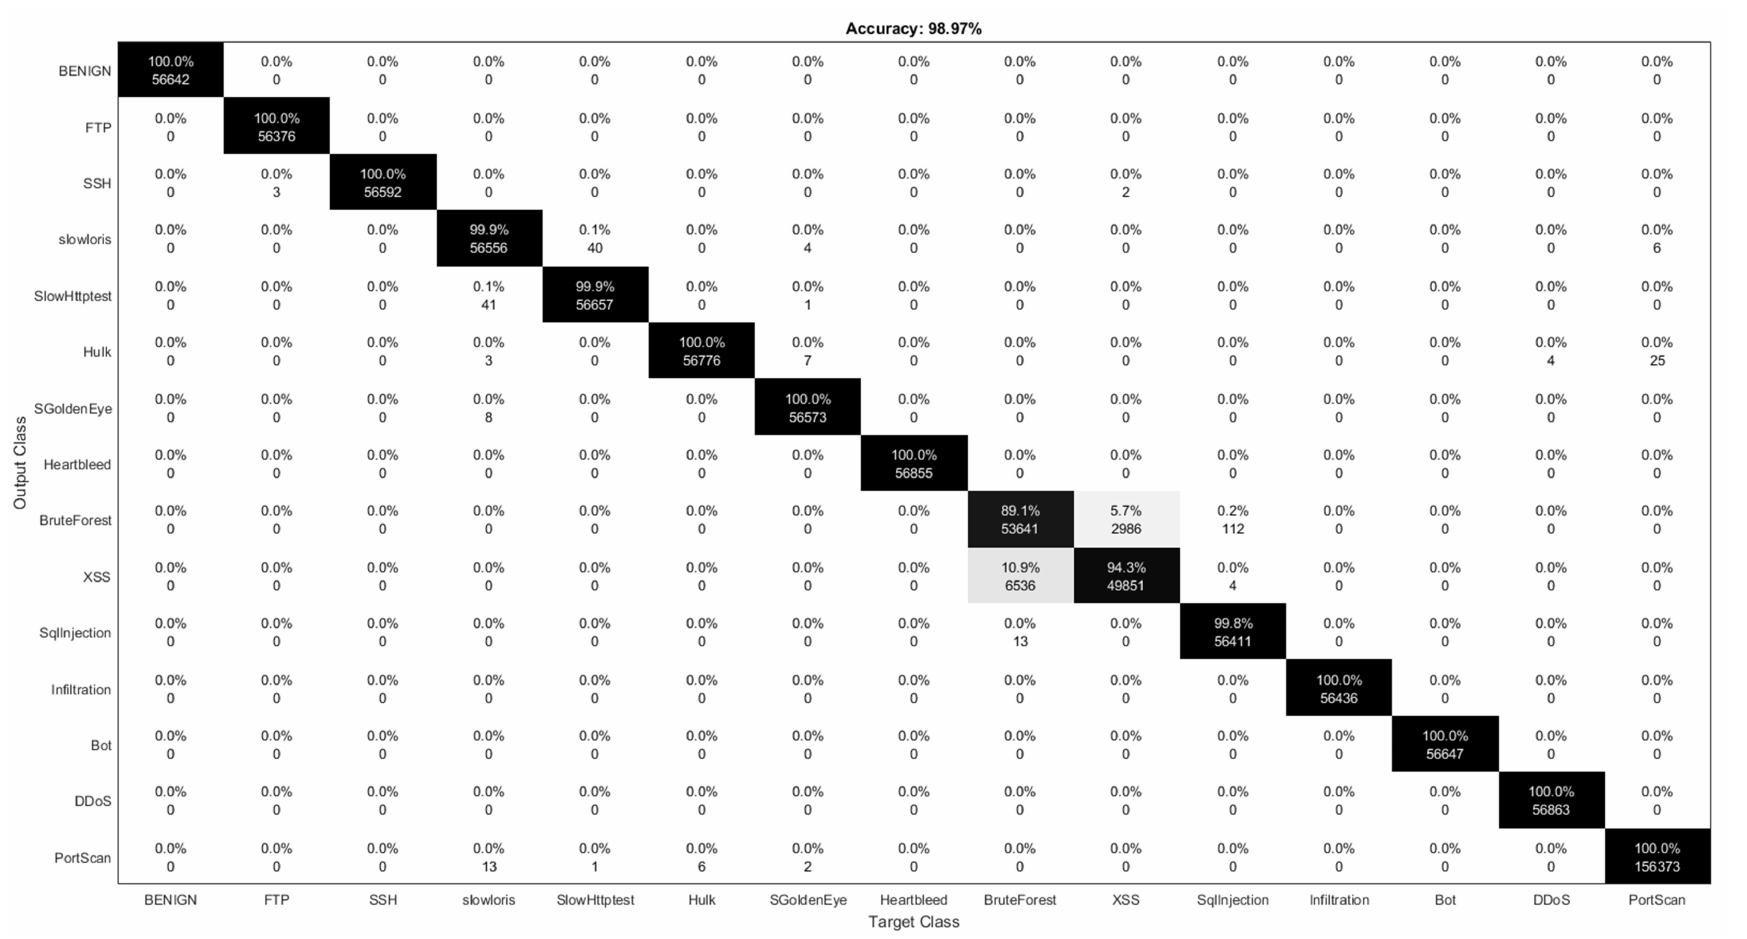
Figure 10. Confusion Matrix for ( PCA − RF ) Mc − 10 with